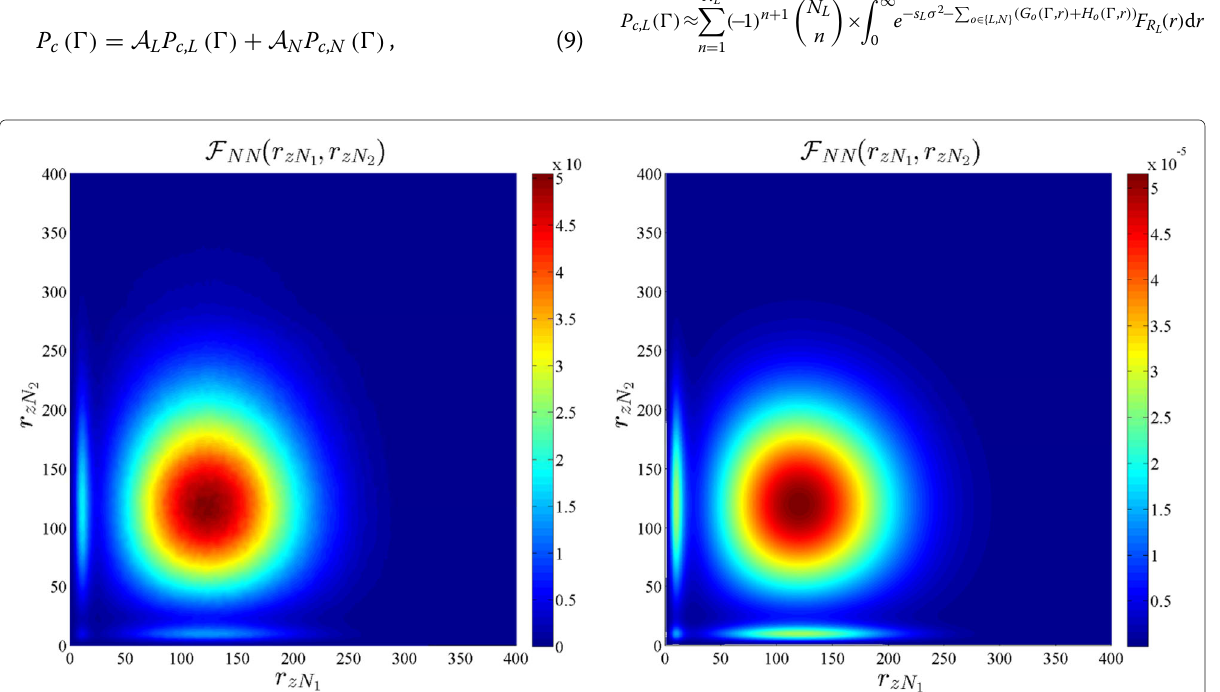
Fig. 4 Joint densities of R zN 1 and R zN 2 for the actual PPP model (left) and the independence assumption (right). R zN 1 and R zN 2 are the distances of LOS users to their respective BSs in two neighboring